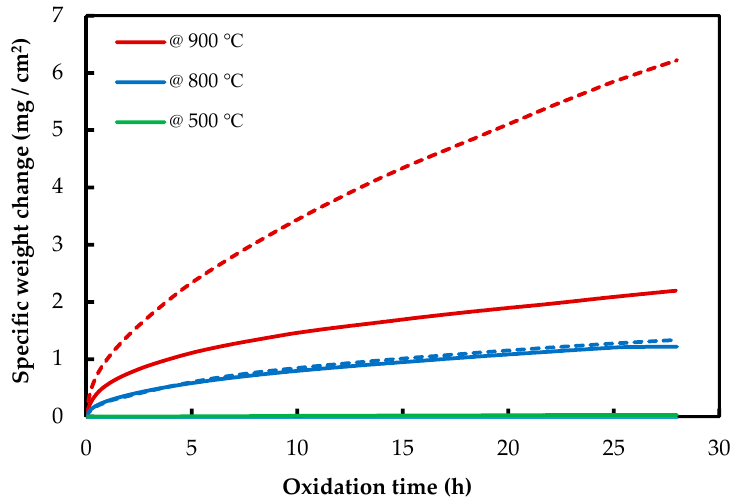
Table 2. Calculated parabolic rate constants for AM and CON NiTiHf and AM NiTi. 𝐾 (cid:3043) unit is